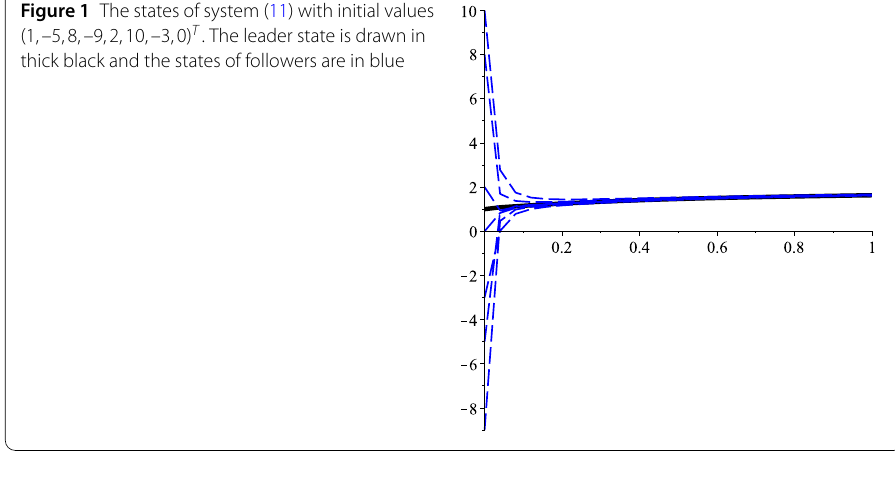
Figure 2 The states of system (11) with initial values (18,–50,80,–19,20,60,–33,0) T . The leader state is drawn in thick black and the states of followers are in blue